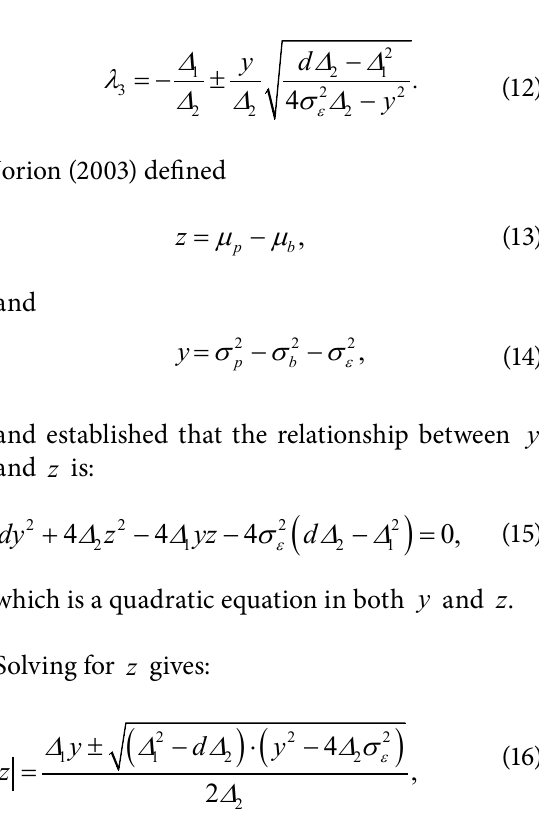
Figure 2. TE frontier, TE -constrained portfolio and constant TE frontier (with 5% TE = ). (a) shows the naïve portfolio: excess return is maximised for a given TE constraint. (b) shows Jorion’s (2003) suggestion: observe constraints from (a), but restrict portfolio risk to that of the